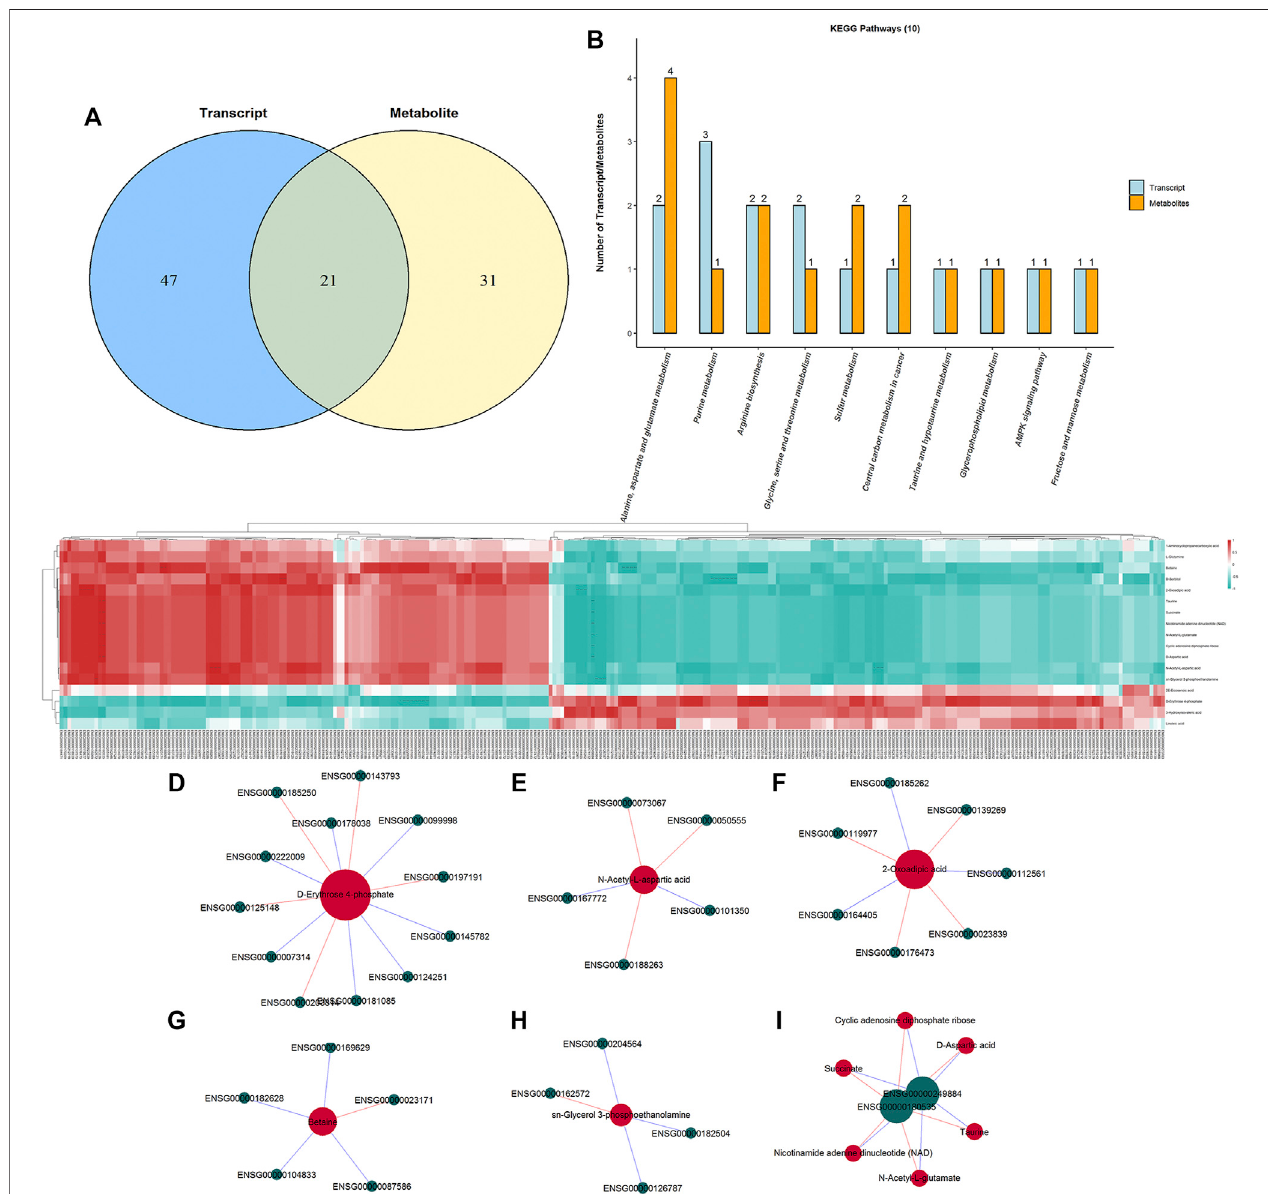
FIGURE7| Integratedenrichmentanalysisoftranscriptandmetabolitepro fi les. (A) KEGGpathwaysthatDEGsandDAMsbothenrichedinwereperformedusinga Venn plot. (B) Histogram of the KEGG pathways (top 10) that DEGs and DAMs both enriched in. (C) Heatmap of the correlation coef fi cient matrix between DEGs and DAMs analyzed by the Pearson correlation. Red indicates the positive correlation, and green indicates negative correlation. The value of the Pearson correlation coef fi cientwasrepresentedbythecolorlabel.Thecorrelationcoef fi cientRisshownincolor.R > 0indicatespositivecorrelation,representedbyred;R < 0indicates negative correlation, represented by green; and darker color indicates stronger correlation. p -value re fl ects the signi fi cance level of correlation. p -value < 0.05 is represented by*, p -value < 0.01 is represented by**, and p -value < 0.001 is represented by***. (D – I) STRING and Cytoscape were used to visualize the networks of DAMs (red nodes) and DEGs (green nodes). Red indicates positive correlation, and blue indicates negative correlation.